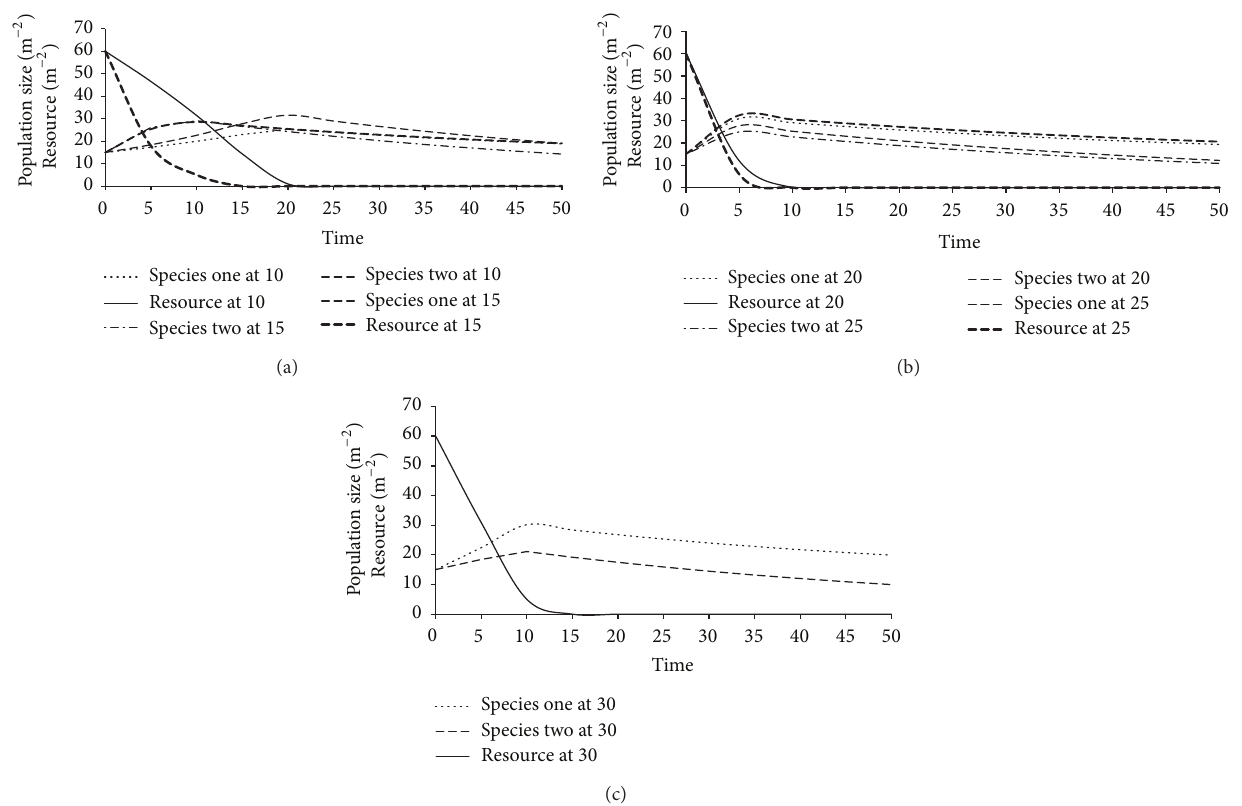
Figure 3: Behavior of the isoclines for two species competing for a single resource when both species initial population size are the same; curves (a)–(c) show the behavior of population size for each species and resource at temperatures: (a) 10 ∘ C and 15 ∘ C, (b) 20 ∘ C and 25 ∘ C, and (c) and 30 ∘ C,